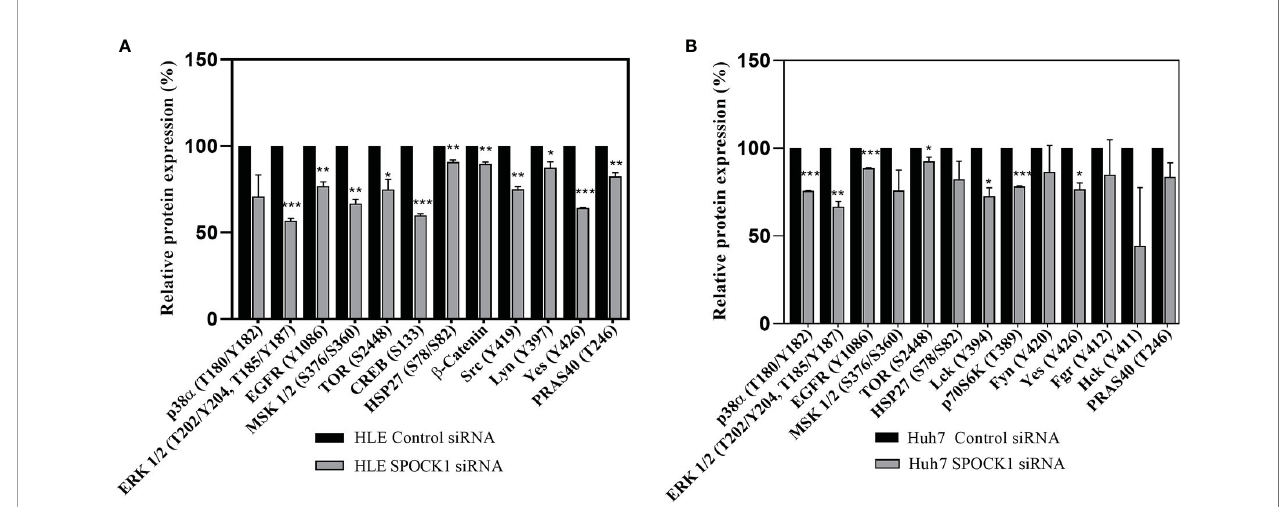
FIGURE 9 | Phosphotyrosine kinase arrays of HLE (A) and Huh7 (B) cells showing the changes as an effect of SPOCK1 silencing by siRNA. Downregulation of SPOCK1 was accompanied by decreased activation of EGFR, and MAPK pathways in both HLE and HuH7 cell lines together with several members of the Sarc family. The inhibition was more effective in the highly aggressive HLE cell line where MSK1, Creb, mTOR, and b -catenin were also affected. *p < 0.05, **p < 0.01, ***p < 0.001.